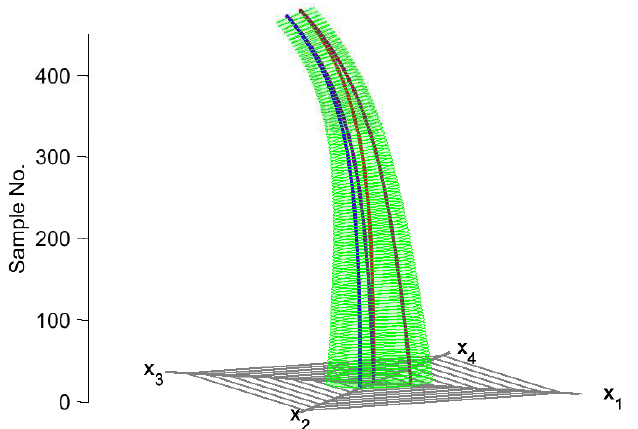
Figure 7. The confidence region at every data point drawn (green) for an illustrative batch process data set resembles a funnel or tube in 3D.